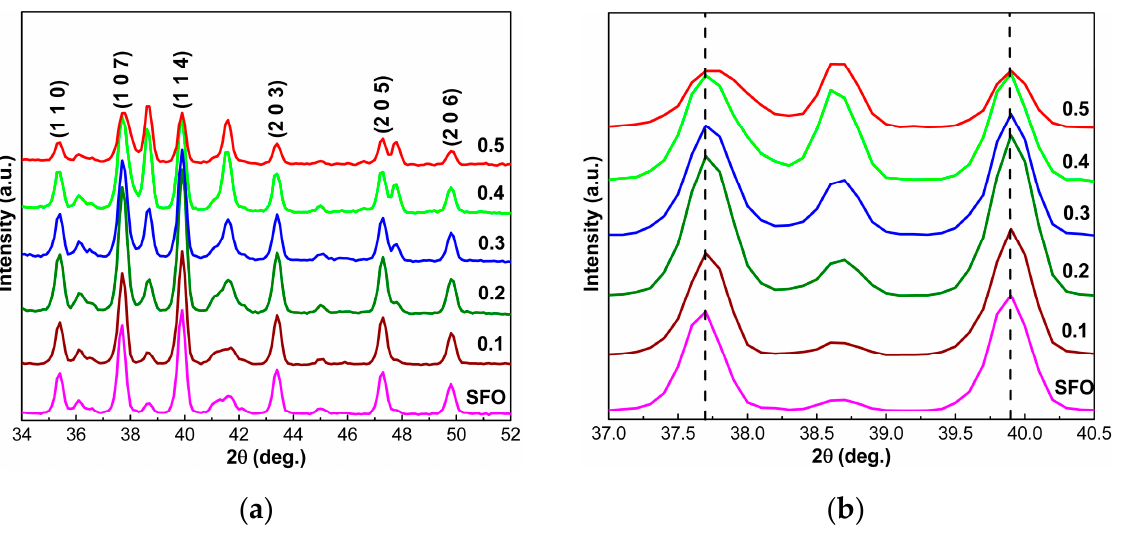
Figure 2. XRD spectra of hexaferrite powders SrFe 12-x Nd x O 19 (0 ≤ x ≤ 0.5) ( a ) and diffraction spectra fragments in the range of 2 θ from 37° to 40.5° ( b ). Table 1. The volume fraction of phases and Rietveld parameters of X-ray diffraction spectra